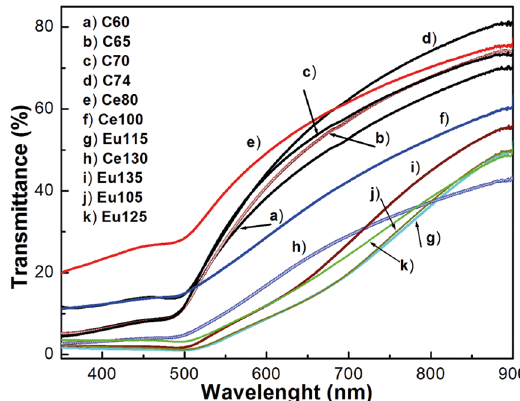
Figure 5. Transmittance spectra of CdS samples synthesized at different synthesis